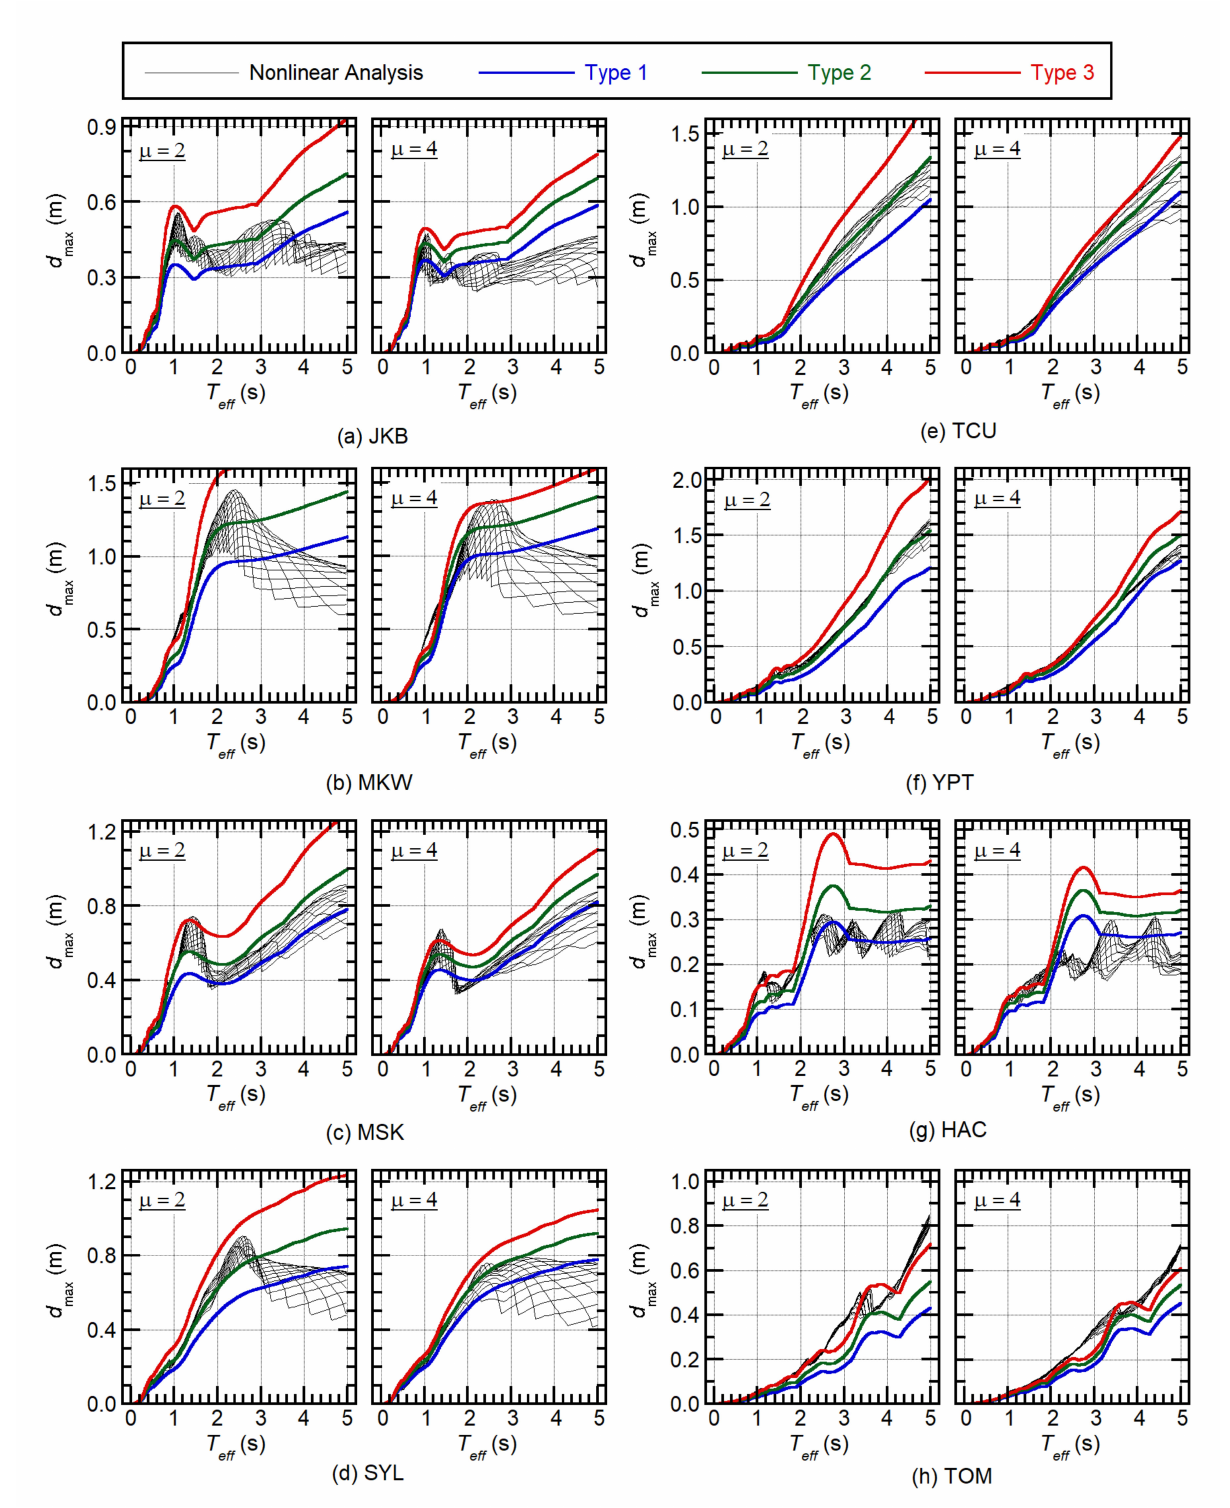
Figure 9. Evaluation of nonlinear peak displacement for each ground acceleration